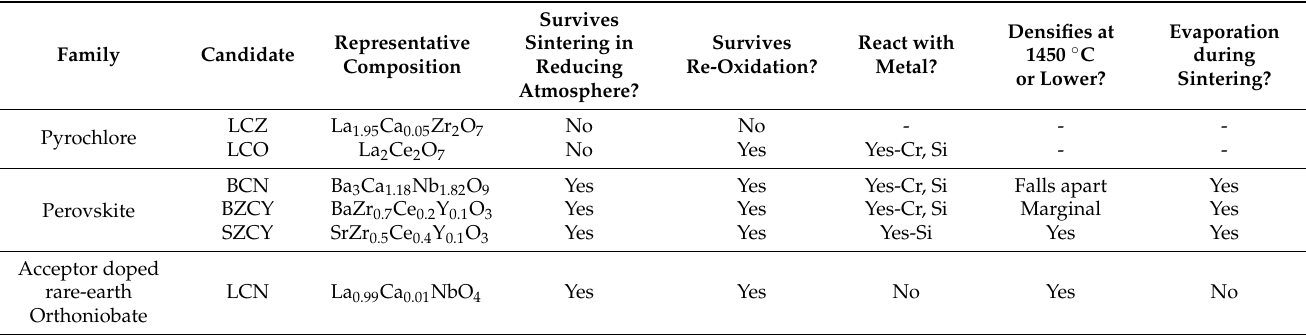
Table 2. Summary of proton conductors’ issues in MSCs